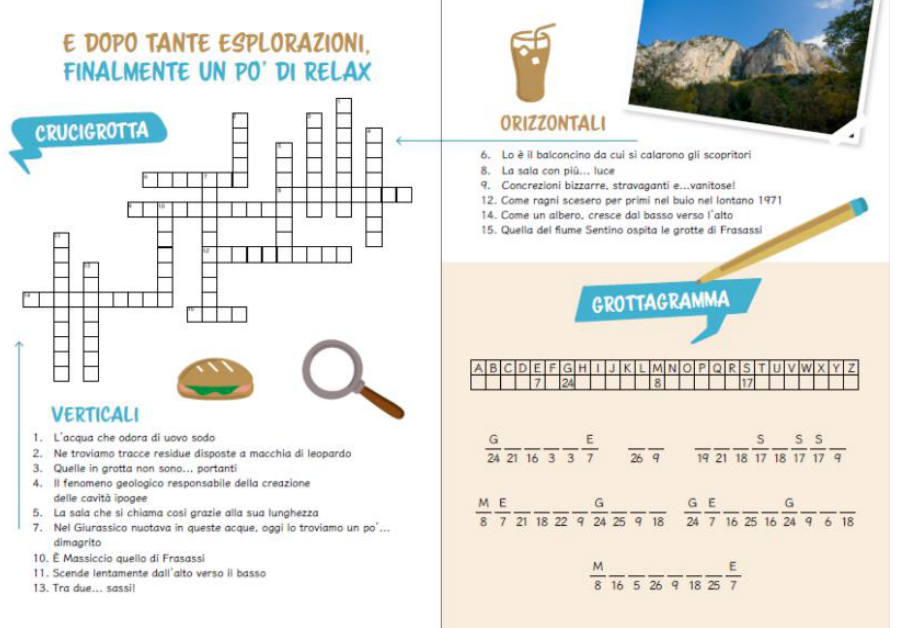
Figure 7. The last exercises of the didactic geological notebooks.